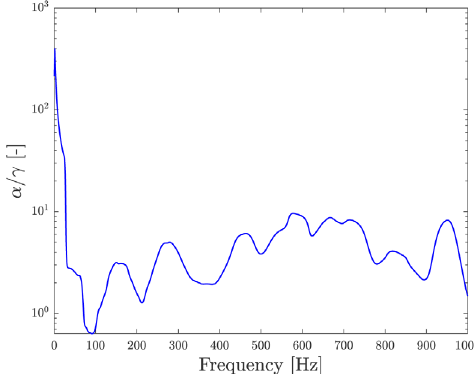
Figure 8. Trend of the a coef fi cient as a function of the